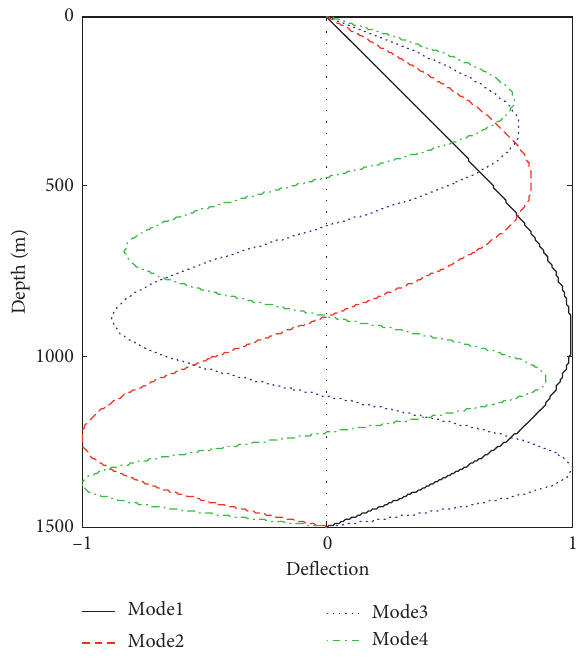
Figure 3: Mode shapes of